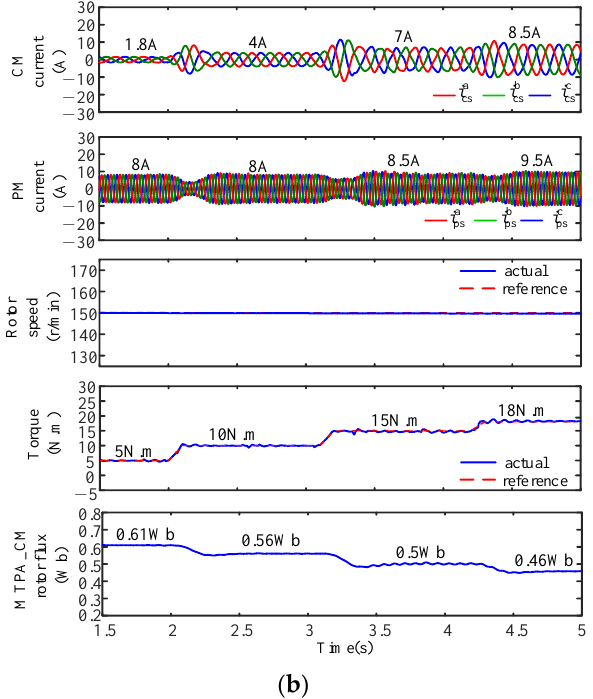
Figure 9. Simulation experiment results when the torque changes. ( a ) SFV-FLC control method; ( b ) MTPA-(SFV-FLC) control method.